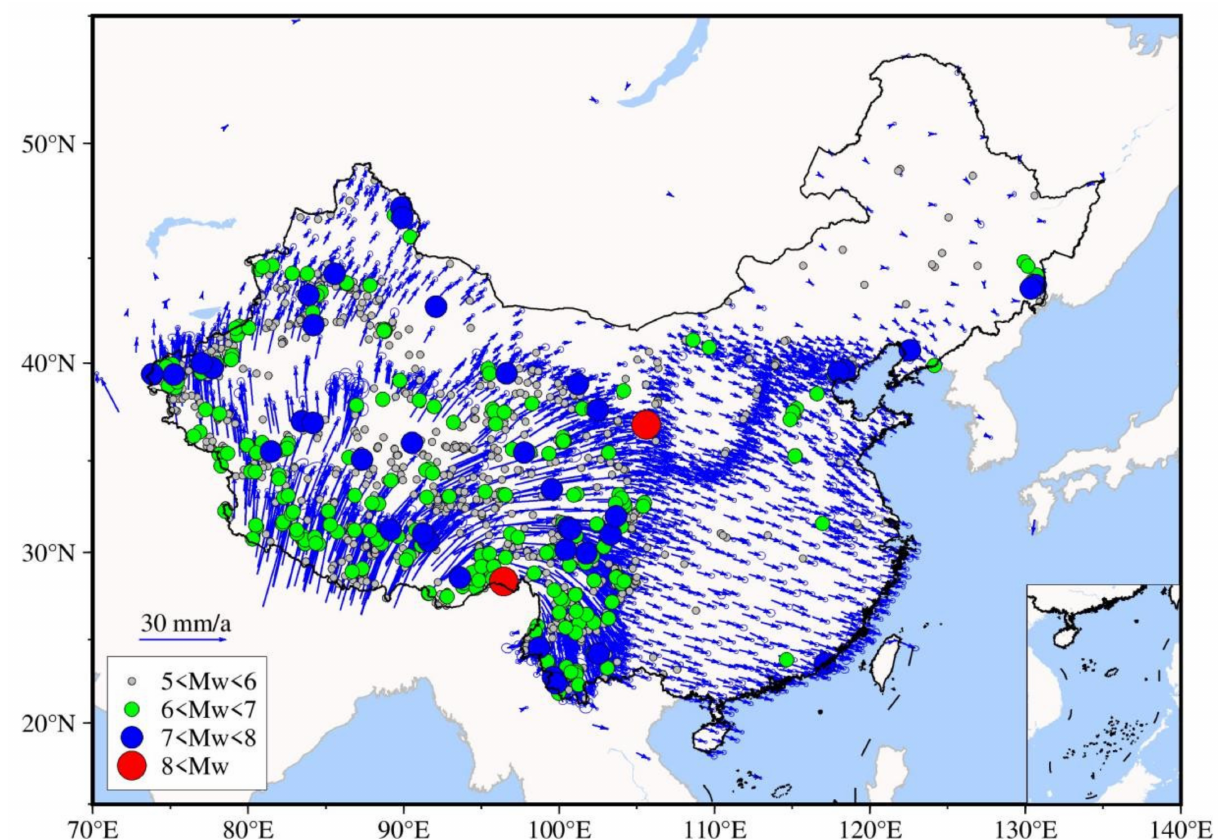
Figure 9. The distribution of strong earthquake and GNSS horizontal velocity